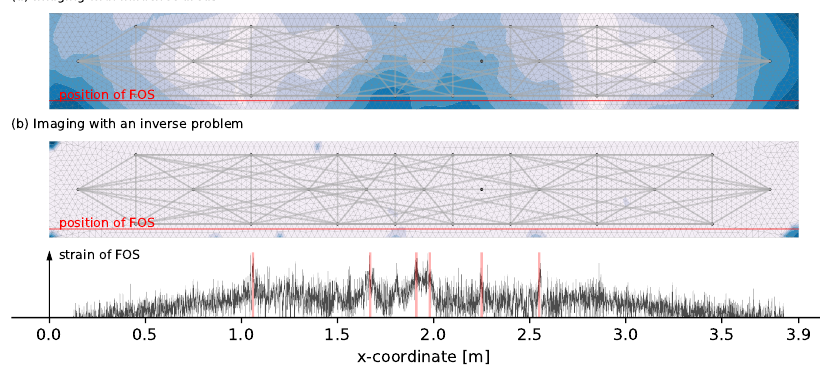
Figure 7. Evaluation at load step 3 with 15 kN load applied with the two different methods of imaging from Sections 2.4 and 2.5 shown in ( a , b